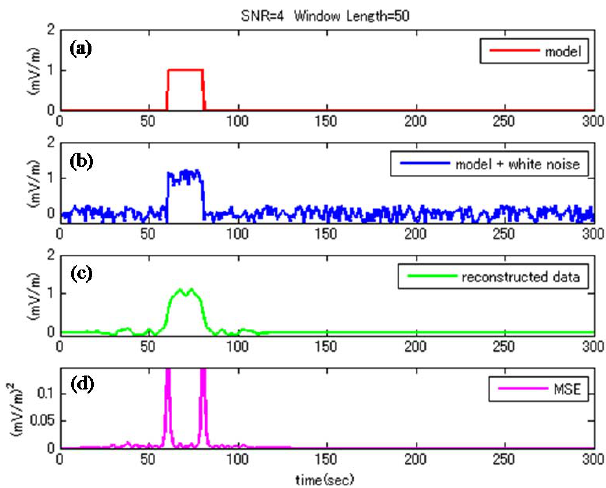
Fig. 9. An example of the simulation results in the case of SNR=4, WL=50, D =20, N =1. (a) The assumed DC-driven train noise, (b) the simulated data ( (a) ,+white noise), (c) reconstructed data of the model with high correlation using SSA procedure, and (d) MSE.